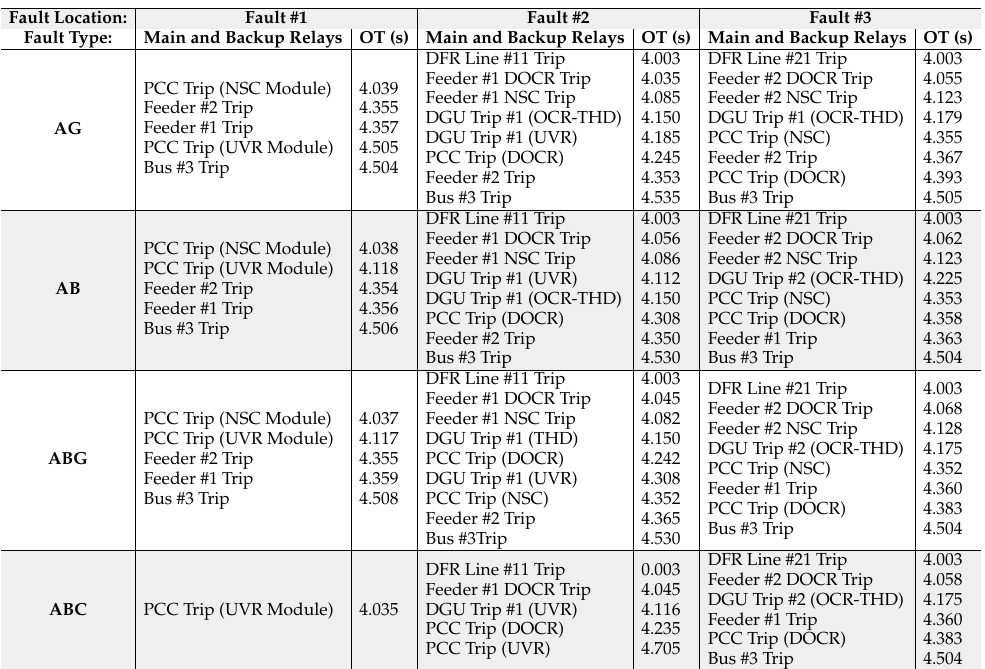
Table 3. Simulation results under different fault conditions in grid connected